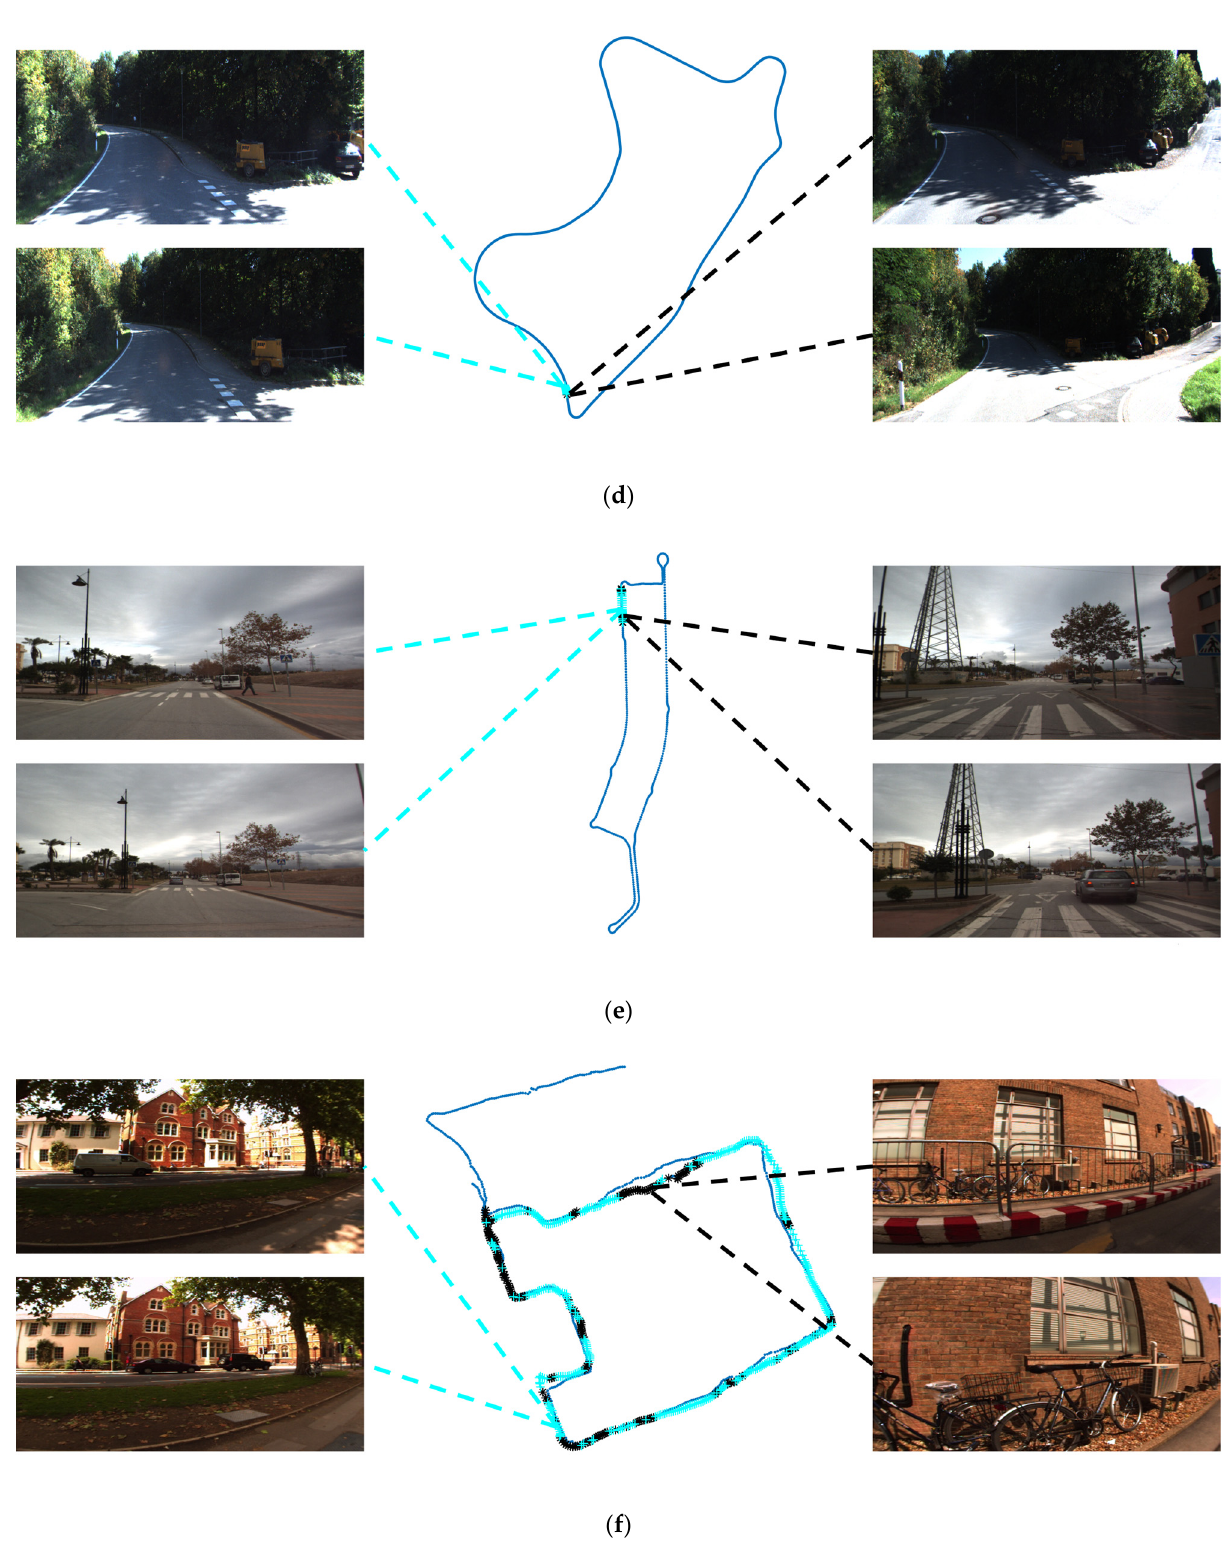
Figure 7. Trajectories of the six datasets and all detected loop closures and false negative loop closures at 100% precision. ( a ) Results of the proposed method on KITTI00. ( b ) Results of the proposed method on KITTI05. ( c ) Results of the proposed method on KITTI06. ( d ) Results of the proposed method on KITTI09. ( e ) Results of the proposed method on Malaga#8. ( f ) Results of the proposed method on CC.